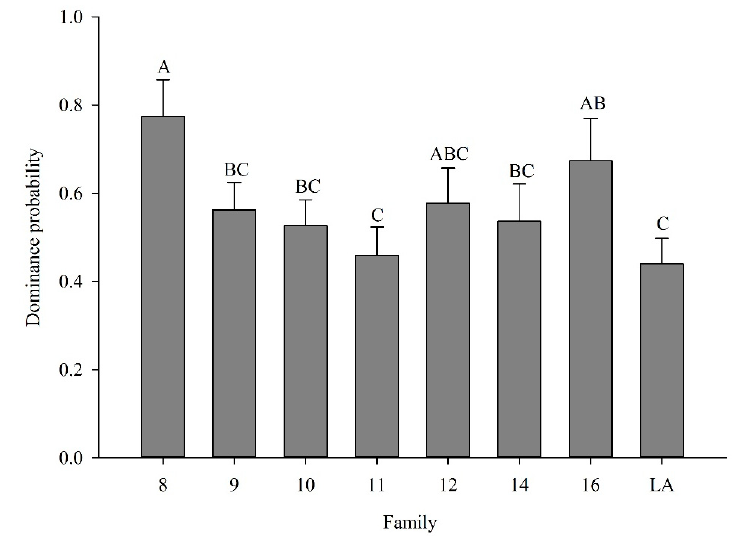
Figure 6. Mean eleventh-year dominance probability ( ± standard error) among families. Letters indicate significant differences ( α = 0.05). LA indicates locally available seedling treatment.